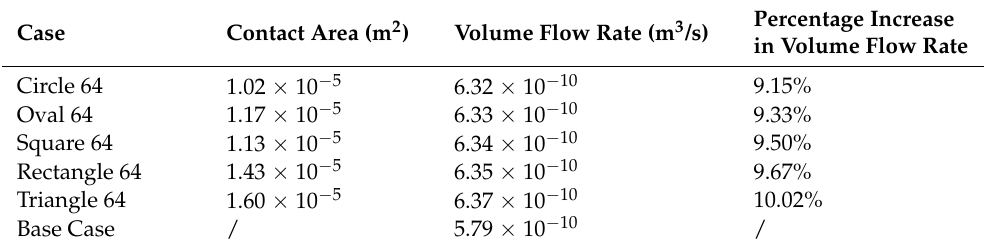
Table 5. Effect of the microchannel contact area on the volume flow rate: data for cases with a 64 pixel 2 (0.2273 mm 2 )